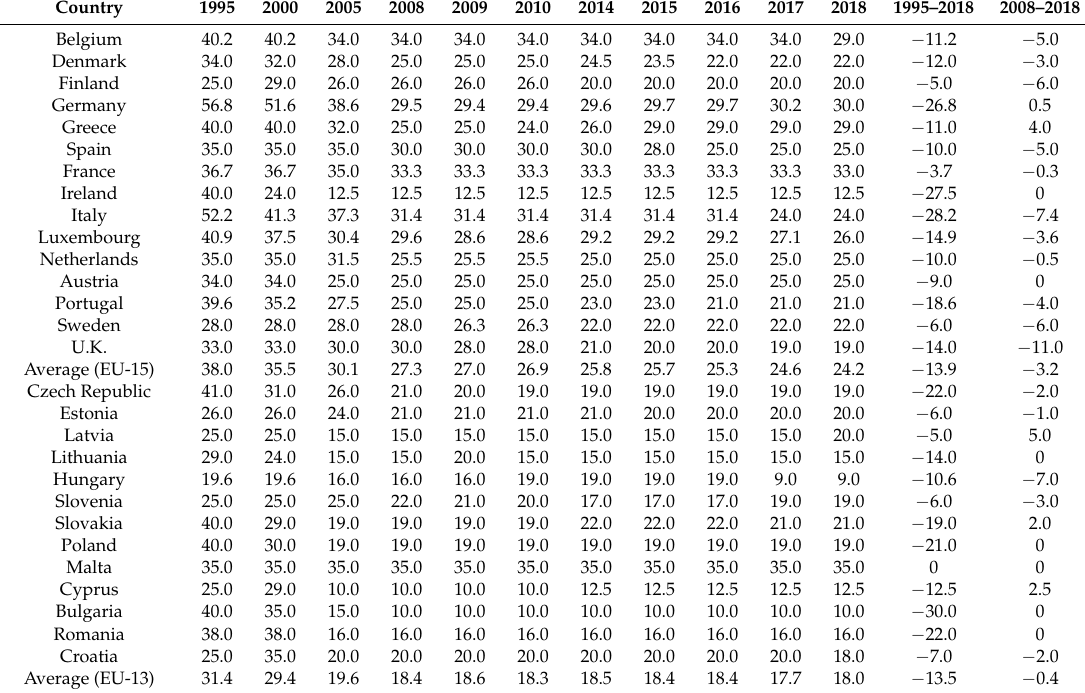
Table 1. The corporate income tax rate dynamics in the EU, 1995–2018.